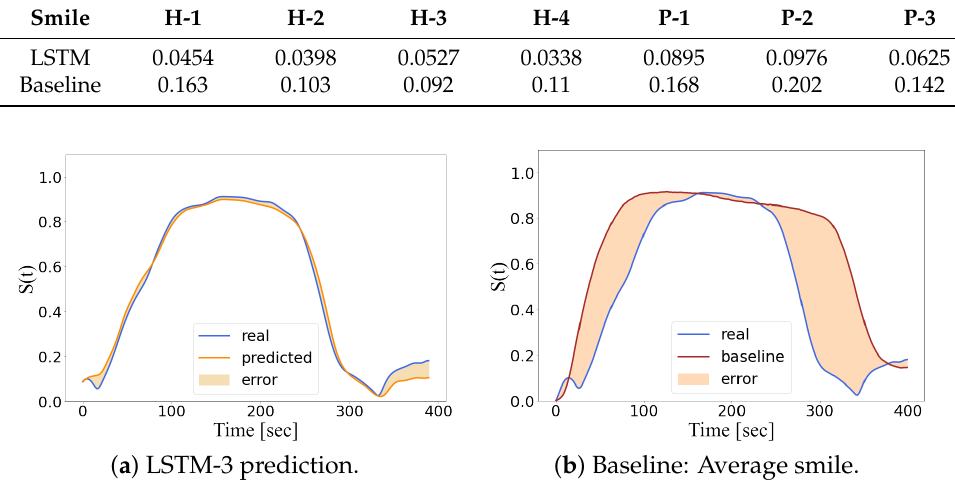
Figure 7. Predictions of the left oral commissure marker on a healthy smile.